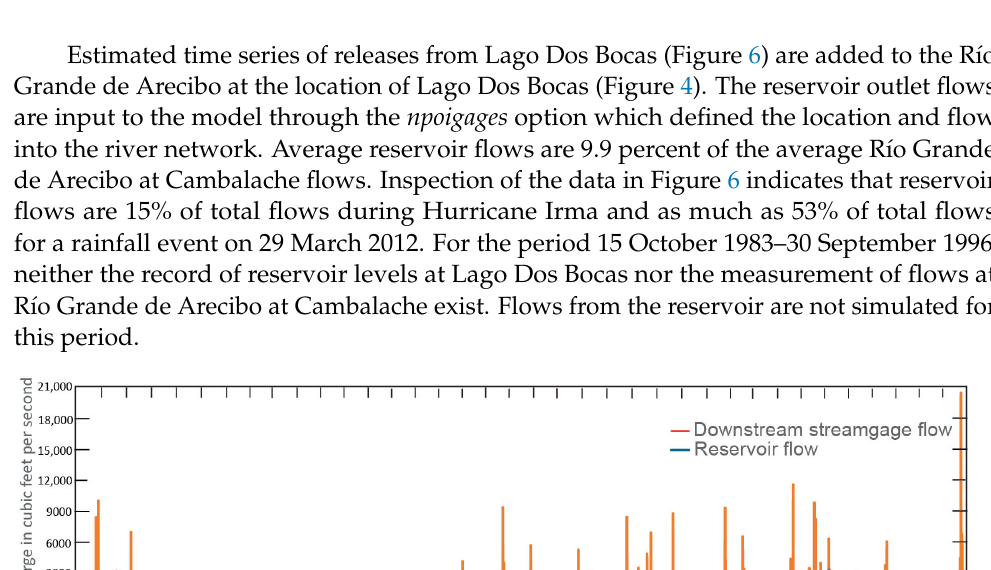
Figure 5. Regression equations for flows from Lago Dos Bocas.